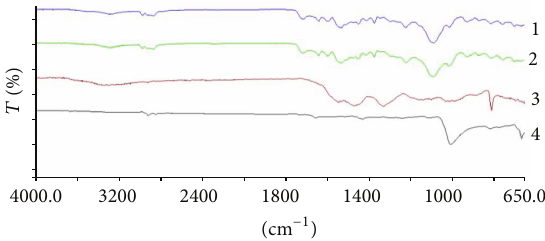
Figure 3: Infrared spectroscopy of different fireproof